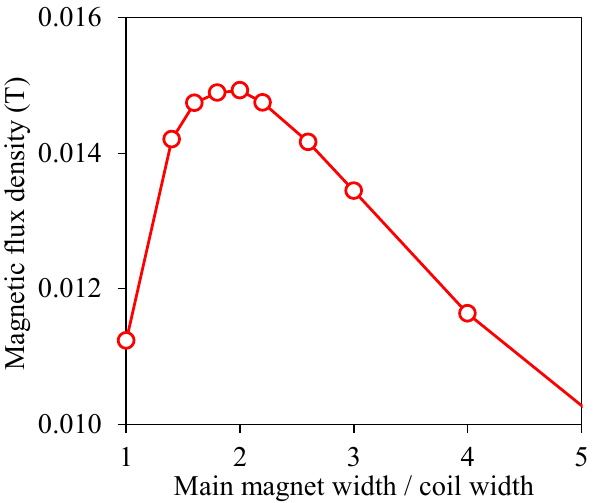
Figure 6. Variation of magnetic flux density according to the ratio of the main magnet width ( w m ) to the coil width ( w e ).